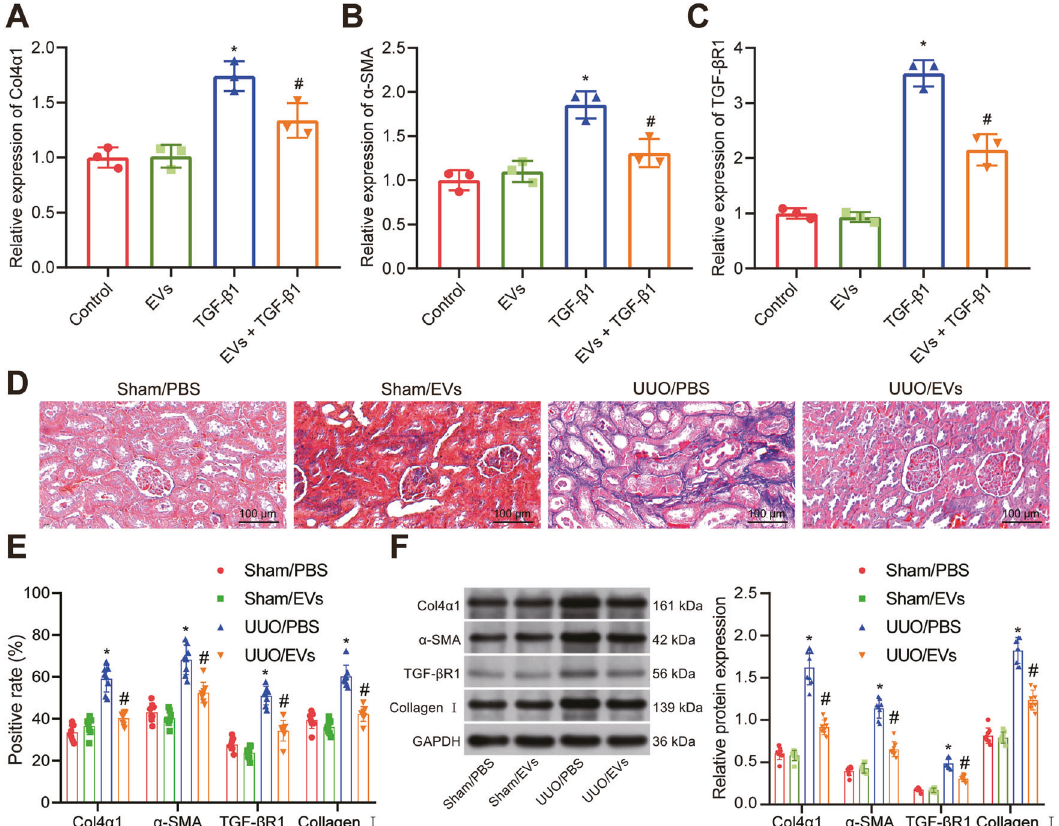
Fig. 1 BMSC-EVs inhibit renal fi brosis in vitro and in vivo. A RT-qPCR measurement of Col4 α 1 expression in HK-2 cells after treatment with TGF β -1 and BMSC-EVs. B RT-qPCR measurement of α -SMA expression in HK-2 cells after treatment with TGF β -1 and BMSC-EVs. C RT-qPCR measurement of TGF- β R1 expression in HK-2 cells after treatment with TGF β -1 and BMSC-EVs. In the panels of ( A , B , C ) * p < 0.05 vs . control. # p < 0.05 vs . TGF β -1. D Masson ’ s trichrome staining for the deposition of collagen in the renal tissues from UUO rats treated with BMSC-EVs ( n = 8). E Immunohistochemistry assay of Col4 α 1, α -SMA, TGF- β R1 and collagen I in renal tissues from UUO rats treated with BMSC-EVs ( n = 8). F Western blot analysis of Col4 α 1, α -SMA, TGF- β R1, and collagen I in renal tissues from UUO rats treated with BMSC-EVs. In the panels of ( E , F ) * p < 0.05 vs . rats receiving sham operation and injected with PBS. # p < 0.05 vs . rats undergoing UUO surgery and injected with PBS. The cell experiment was repeated three independent